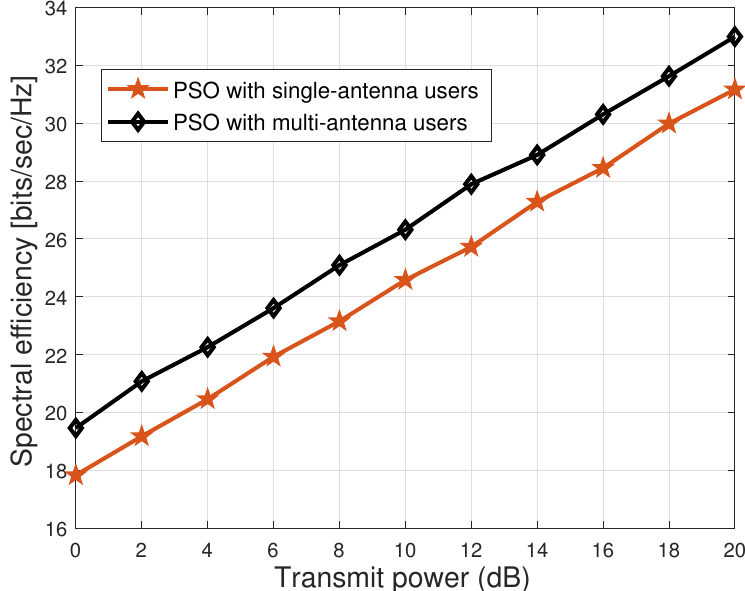
Figure 8. Spectral efficiency comparison between single-antenna and multi-antenna